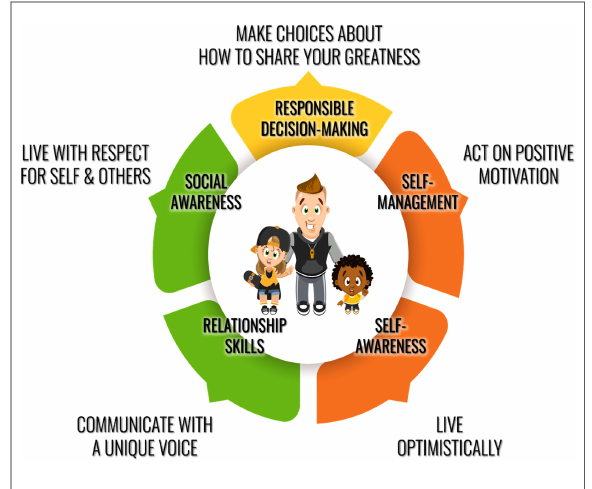
FIGURE 1 Believe in You empowerment rights. Used with permission from Varsity